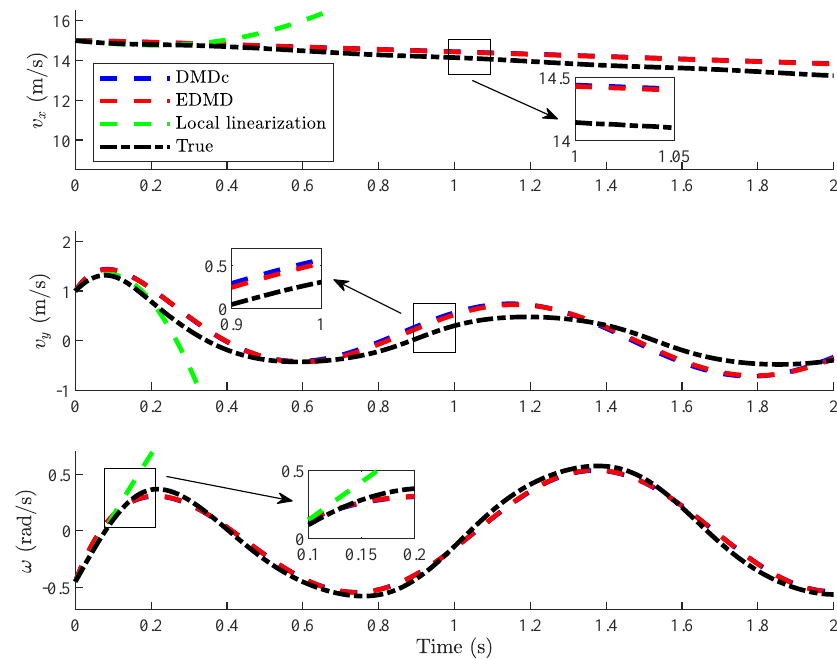
Figure 9. Validation of the Koopman linear model (Scenario